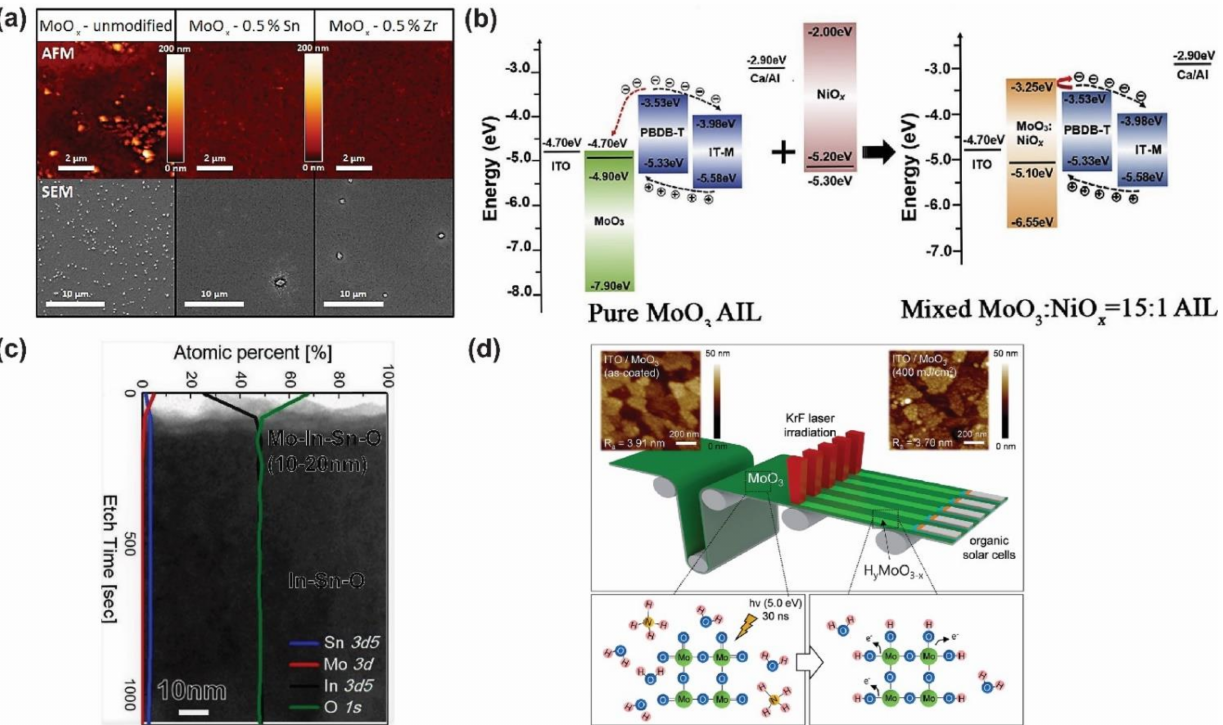
Figure 4. ( a ) AFM and SEM images of unmodified and modified MoOx HTL. Adapted with permis- sion from [112]. ( b ) Energy levels of pristine and doped MoO 3 with a NiOx layer. Adapted with permission from [113]. Copyright 2019, Elsevier. ( c ) XPS depth profile of MGI electrode. Adapted with permission from [126]. Copyright 2016, Elsevier. ( d ) Scheme of laser-assisted synthesis of H y MO 3-x . Adapted with permission from [129]. Copyright 2016, Royal Society of